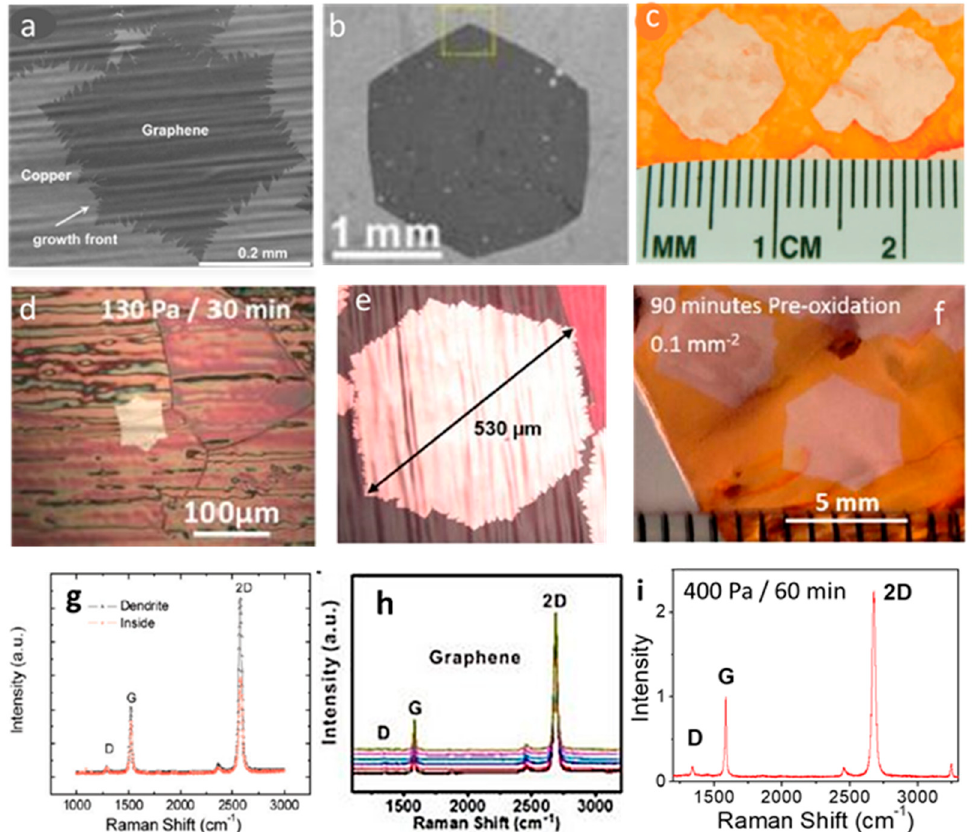
Figure 3. Growth progression of large single-crystal graphene grains on Cu by CVD of methane ( a – c ) and ethanol ( d – f ). ( a ) SEM image of monolayer single-crystal graphene grain grown at 1035 ◦ C for 90 min (0.5 sccm CH 4 flow rate and 8 mTorr CH 4 partial pressure) with dimensions of up to 0.5mm and ( g ) its corresponding Raman spectrum within the bulk of the film and along the dendrite. Adapted from [34] with permission of the American Chemical Society, Copyright 2011. ( b ) SEM image of one large size mono-layer graphene domain (~2.3 mm) grown at 1077 ◦ C for 125 min (0.15 sccm CH 4 flow rate, 70 sccm H 2 ), transferred onto SiO2 / Si, and ( h ) its corresponding Raman spectrum of six di ff erent spots. All Raman spectra are indicative of high-quality monolayer graphene and reveal the overall uniformity of the film. Adapted from [74] with permission of the American Chemical Society, Copyright 2012. ( c ) Photographic image of centimeter-sized single-crystal graphene grown for 12 h on Cu foil after oxidation for 5 min (1.0 × 10 − 3 Torr CH 4 partial pressure). Adapted from [81] with permission of The American Association for the Advancement of Science, Copyright 2013. ( d ) Optical image of mono-layer single-crystal graphene grain with dimensions of up to 90 µ m grown at 1070 ◦ C for 30 min (1.5 × 10 − 3 sccm of ethanol and 130 Pa of total pressure). ( e ) Optical image of the over 500 µ m mono-layer graphene grain on Cu grown at 1070 ◦ C for 60 min (1.5 × 10 − 3 sccm of ethanol and 400 Pa of total pressure) and ( i ) its Raman spectrum after the transfer on Si / SiO 2 (I 2D / I G = 2.5 and I D / I G = 0.1). Adapted from [84] with permission of the American Chemical Society, Copyright 2018. ( f ) Hexagonal single-crystal graphene grown at 1065 ◦ C for 22 h (0.03 sccm of ethanol and 300 Pa of total pressure) with dimensions of 5 mm obtained with Cu pre-oxidation for 90 min. Adapted from [67] with permission of Elsevier, Copyright